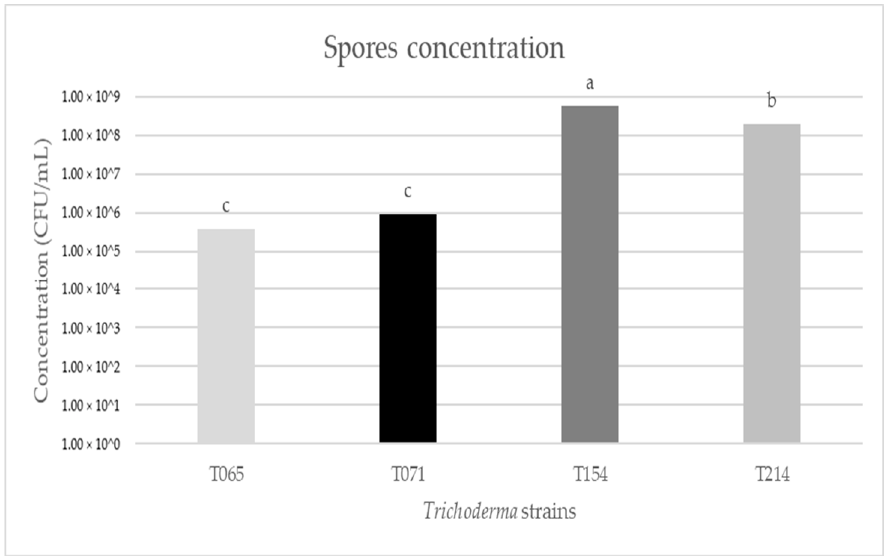
Figure 3. Spore production at 25°C after 7 days in a PDA plate. Values followed by the same letter do not differ significantly ( p = 0.05).